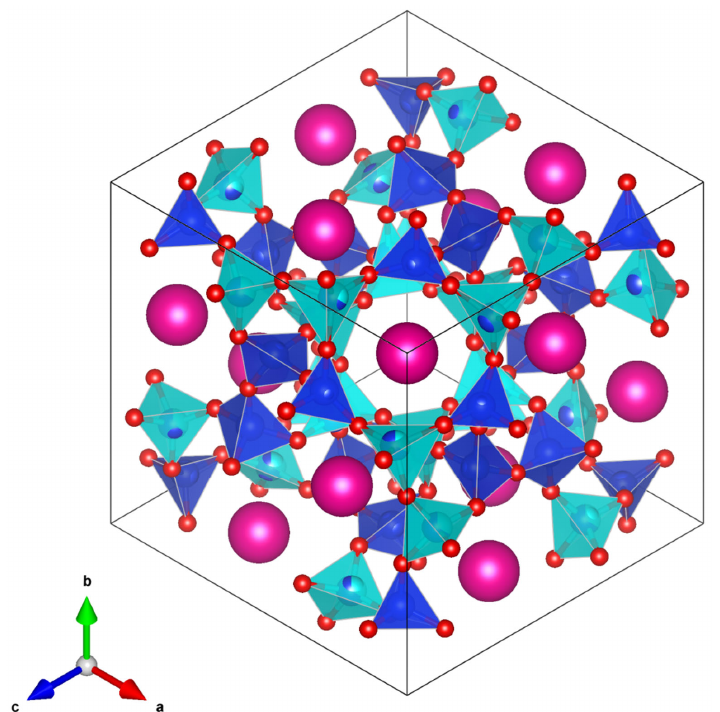
Figure 13. VESTA plot showing the 457 K (MgO calibrated temperature) 𝑃𝑎 3 cubic crystal structure of Rb 2 CoSi 5 O l2 . Pink spheres represent Rb + cations, red spheres represent O 2 − anions, dark blue tetrahedra represent SiO 4 units and light blue tetrahedra represent (Si 2/3 Co 1/3 )O 4 units. Thermal expansion due to the increase in temperature means that the cubic unit cell volume eventually becomes greater than the orthorhombic unit cell volume at 497 K, 40 K higher than the phase transition temperature. The 𝑃𝑎 3 cubic structure is retained up to 1133 K. Above this temperature the Rb 2 CoSi 5 O l2 sample starts to decompose before par ‐ tially melting at 1323 K. Table 8 shows the thermal expansion coefficients (TEC) for the two Rb 2 CoSi 5 O l2 phases. TEC for other leucite phases are given as comparison. It can be seen that the TEC for Rb 2 CoSi 5 O l2 are in the same order of magnitude as those reported for other leucites.